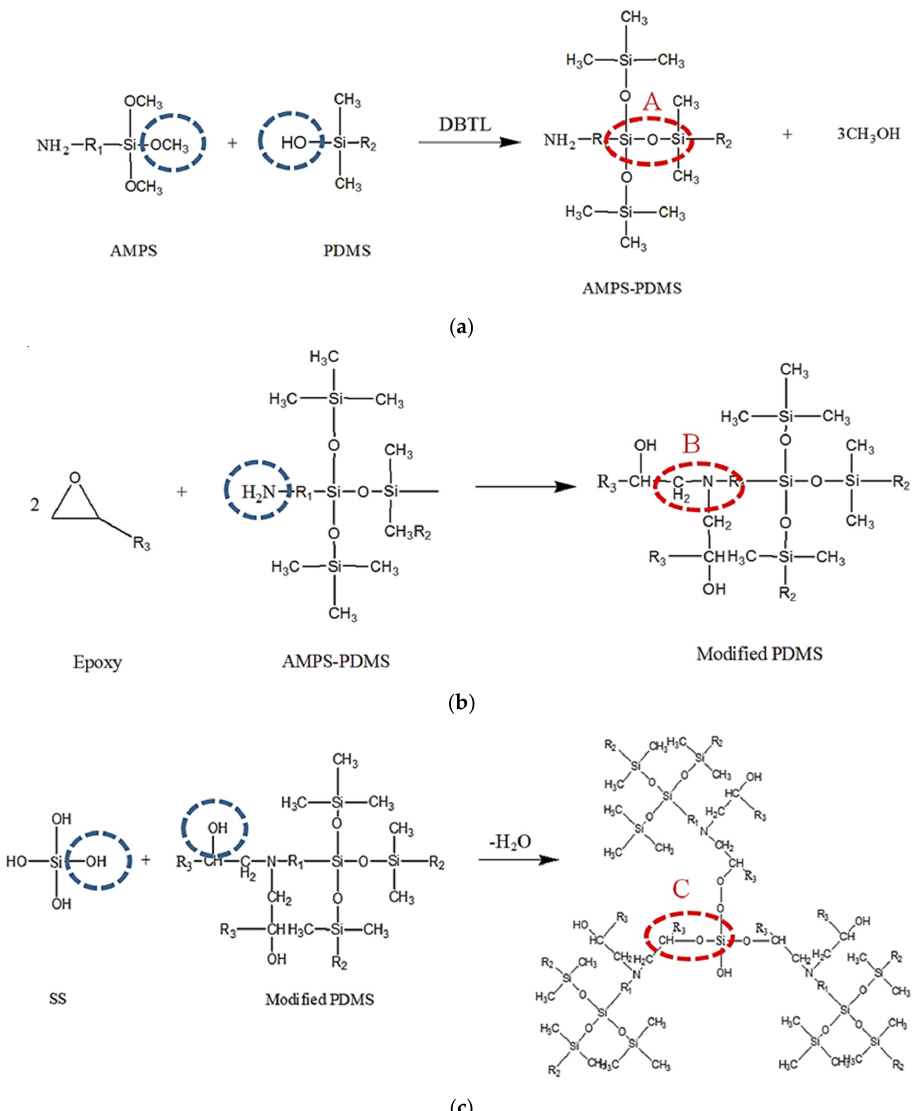
Figure 4. The proposed mechanisms of S3 solution ( a ) reaction between AMPS and PDMS with DBTL as catalyst, ( b ) reaction between epoxy resin and AMPS-PDMS molecules, ( c ) reaction between SS and modified PDMS. R1, R2 and R3 symbolize alkyl